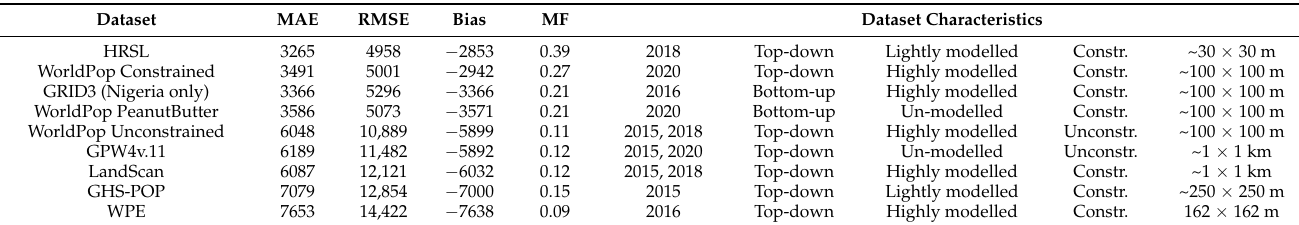
Table 2. Summary of error in nine gridded population datasets across 118 Lagos (Nigeria), Port Harcourt (Nigeria), and Nairobi (Kenya) slum settlements compared to field-referenced population counts reported by Know Your City (KYC). Gridded population datasets ordered by most-to-least accurate. Dataset